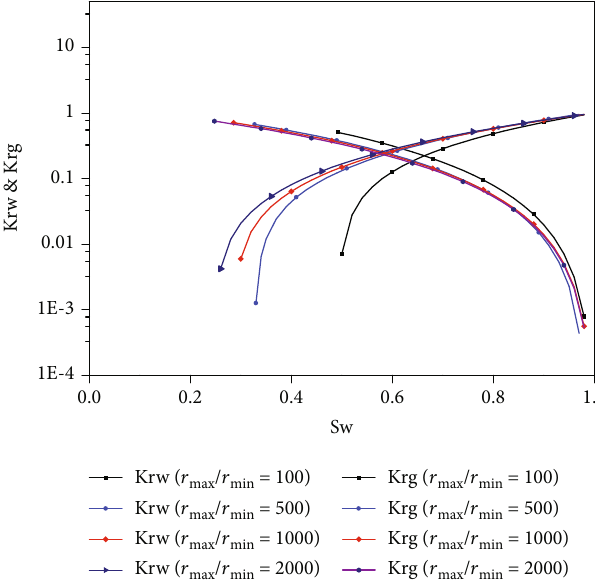
Figure 9: The relationship curve between irreducible water saturation and e ff ective stress under di ff erent ratios of the maximum pore radius to the minimum pore radius.